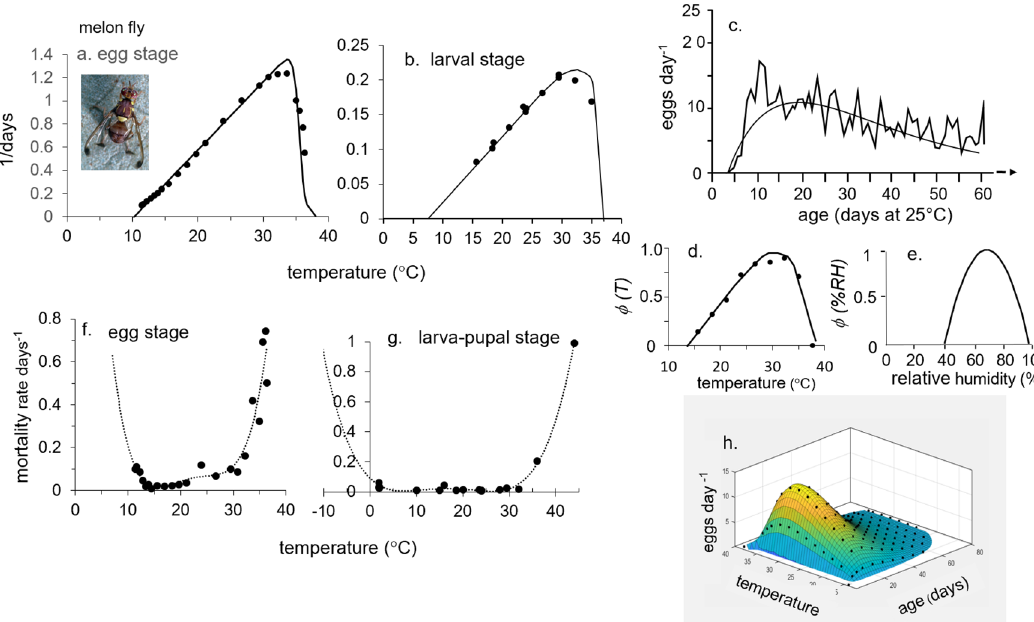
Fig. 6 Biodemographic functions for melon fruit fl y. a , b Rates of development of the egg and larval stages 78 – 80,87 – 92 , c per capita fecundity pro fi le 88 on age in days at 25 °C, d , e temperature ( ϕ (T) ) 88 and inferred relative humidity ( ϕ (RH) ) 93,94 scalars for reproduction, f , g mortality rates for egg stage and for larval-adult stages respectively 95,96 , and h 3-D age speci fi c fecundity pro fi les corrected for the effects of ϕ (T) . The clip of melon fl y is by Jack Kelly Clark, University of California Statewide IPM